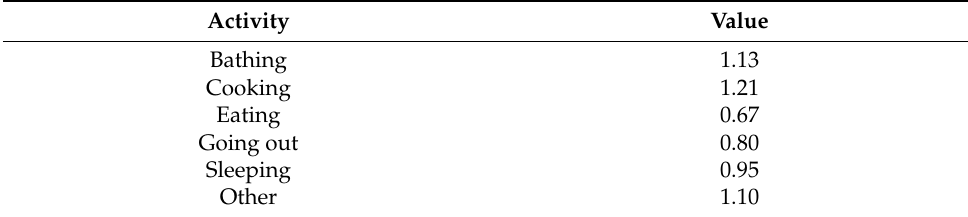
Table 3. Biometric indicator for Subject ID1/woman.